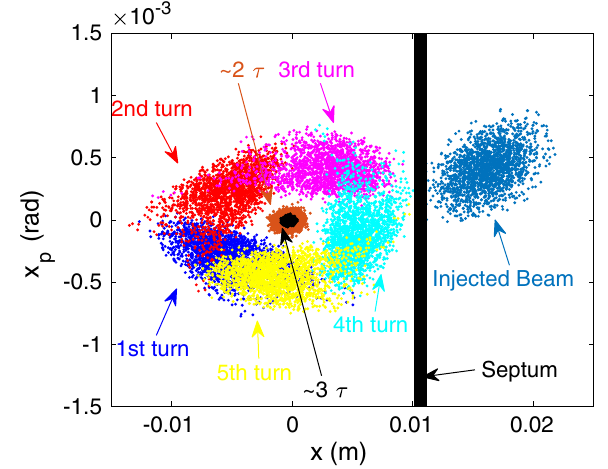
FIG. 11. Beam distribution for the first few turns and 2 and 3 damping times after the NLK injection. The thin septum sheet location is indicated by the vertical black bar.